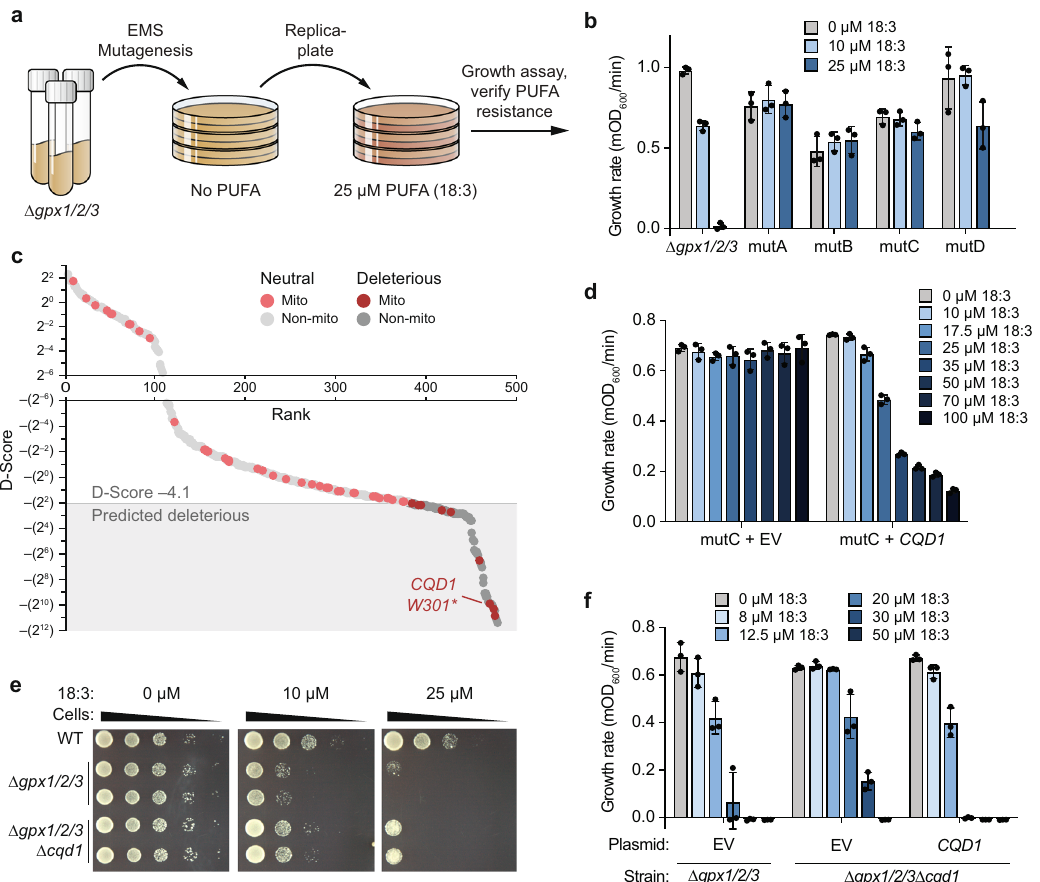
Fig. 2 Genome-wide screen for CoQ traf fi cking genes identi fi es uncharacterized UbiB protein Cqd1. a Schematic of forward-genetic yeast screen for genes involved in CoQ traf fi cking. b Growth rates of Δ gpx1/2/3 and four mutant strains resistant to 18:3 treatment (mutA-D). Yeast were assayed in p ABA – media containing 2% (w/v) glucose with 0 − 25 µ M 18:3 (mean ± SD, n = 3 independent samples). c Mutant strains mutA-D were submitted for whole-genome sequencing to identify non-synonymous mutations (total = 442). Mutations were analyzed with PROVEAN to fi lter for likely deleterious changes (D-score ≤ − 4.1, shaded box). Gray, all genes; red, mitochondrial genes. Light, predicted neutral; dark, predicted deleterious. d Growth rate of mutC yeast expressing empty vector (EV) or endogenous CQD1 (mean ± SD, n = 3 independent samples). Yeast were assayed under the conditions described in ( b ) with 0 − 100 µ M 18:3. e Drop assay of WT, Δ gpx1/2/3 , and Δ gpx1/2/3 Δ cqd1 yeast grown for 3 days on solid p ABA – medium containing 2% (w/v) glucose, 0.5% (w/v) ethanol (EtOH), and 0-25 µ M 18:3. A representative drop assay from three independent experiments is shown. f Growth rates of Δ gpx1/2/3 and Δ gpx1/2/3 Δ cqd1 yeast expressing EV or endogenous CQD1 (mean ± SD, n = 3 independent samples). Yeast were assayed under the conditions described in ( b ) with 0 − 50 µ M 18:3. Source data for panel ( c ) is provided as a Source Data fi